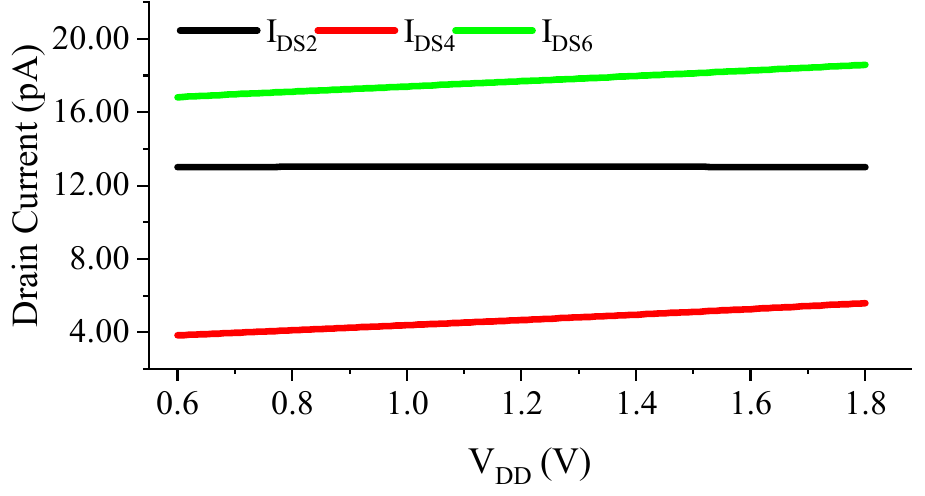
Figure 3. Simulated current biasing of M2.